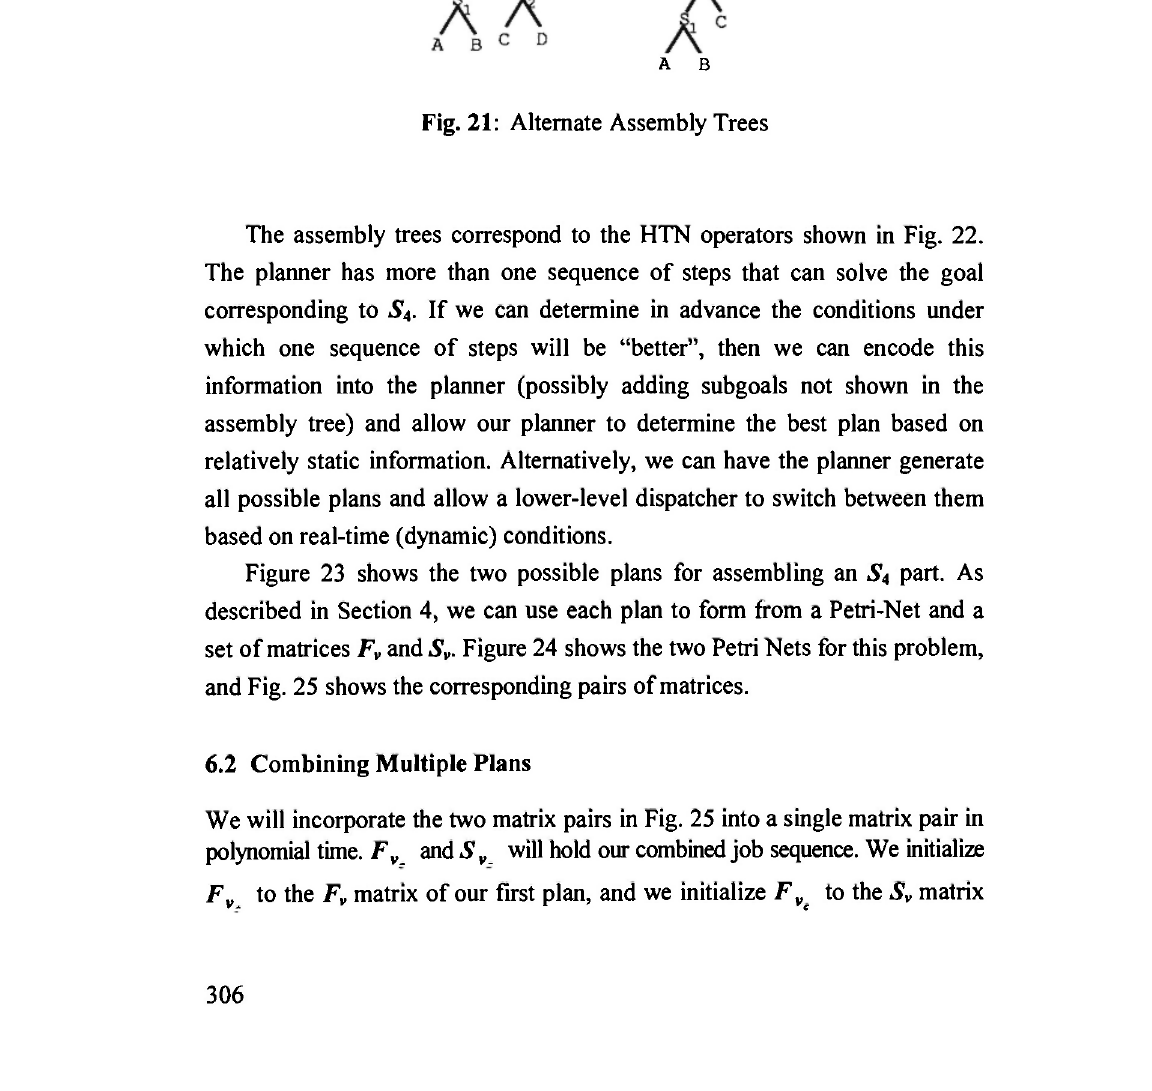
Fig. 21: Alternate Assembly